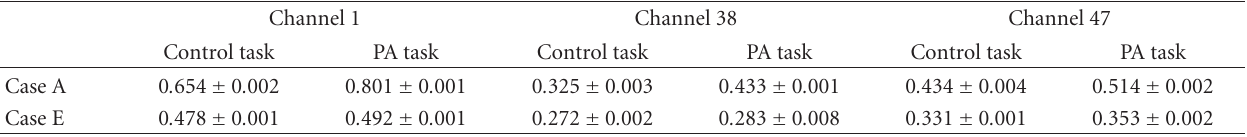
Table 3: Changes in oxyHb concentration in the channels in which both cases A and E had a significant di ff erence in concentration between the control and prism adaptation